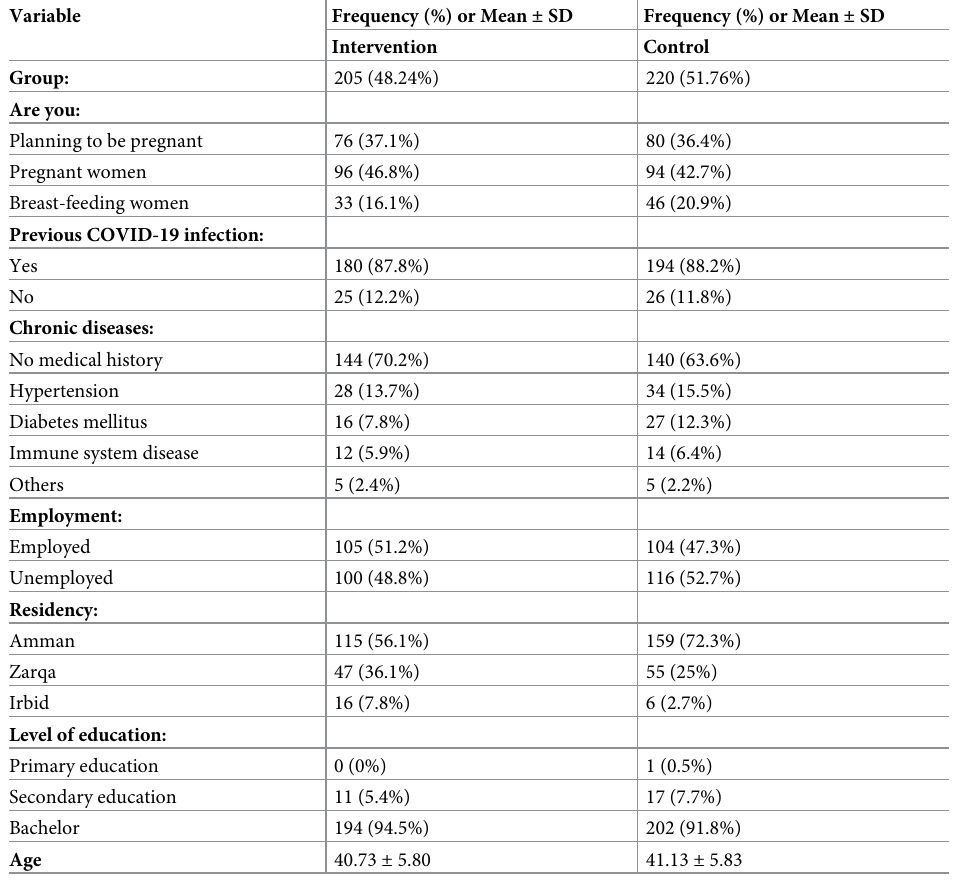
Table 1. Sociodemographic and clinical characteristics of the women.